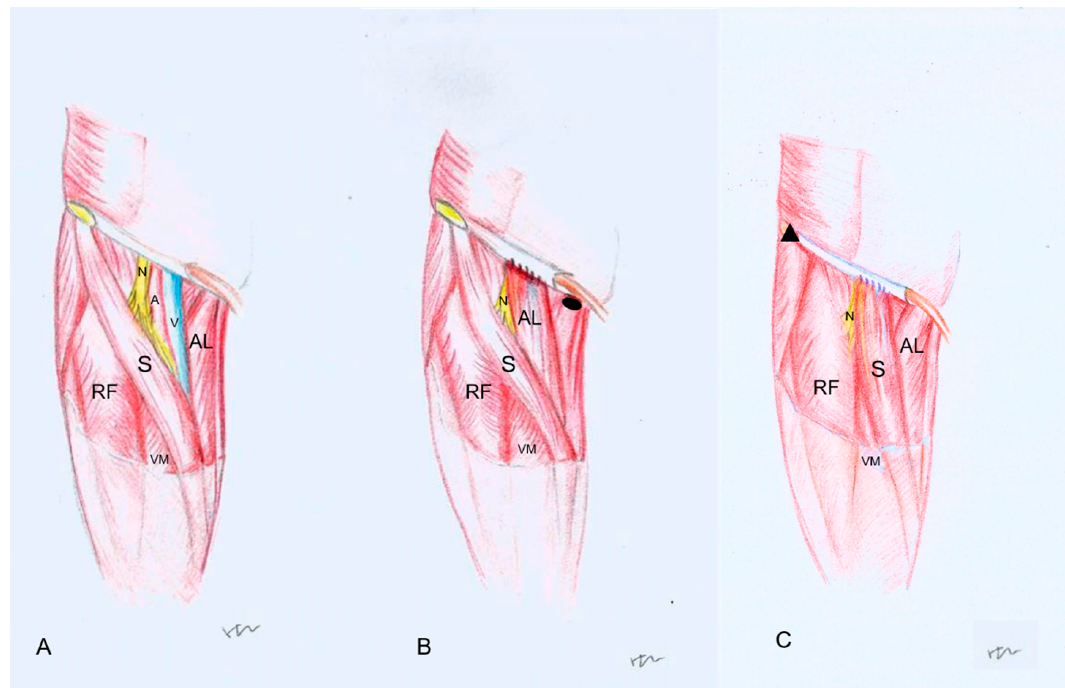
Figure 2. Illustration showing anatomical details of flap reconstruction process: ( A ), after recon- struction with ALF ( B ) and with SAF ( C ) (RF: rectus femoris, AL: adductor longus, S: sartorius, VM: vastus medialis, N: femoral nerve, A: femoral artery, V: femoral vein, black oval: adductor longus attachment of pubis, black triangle: sartorius attachment of superior anterior iliac spine).